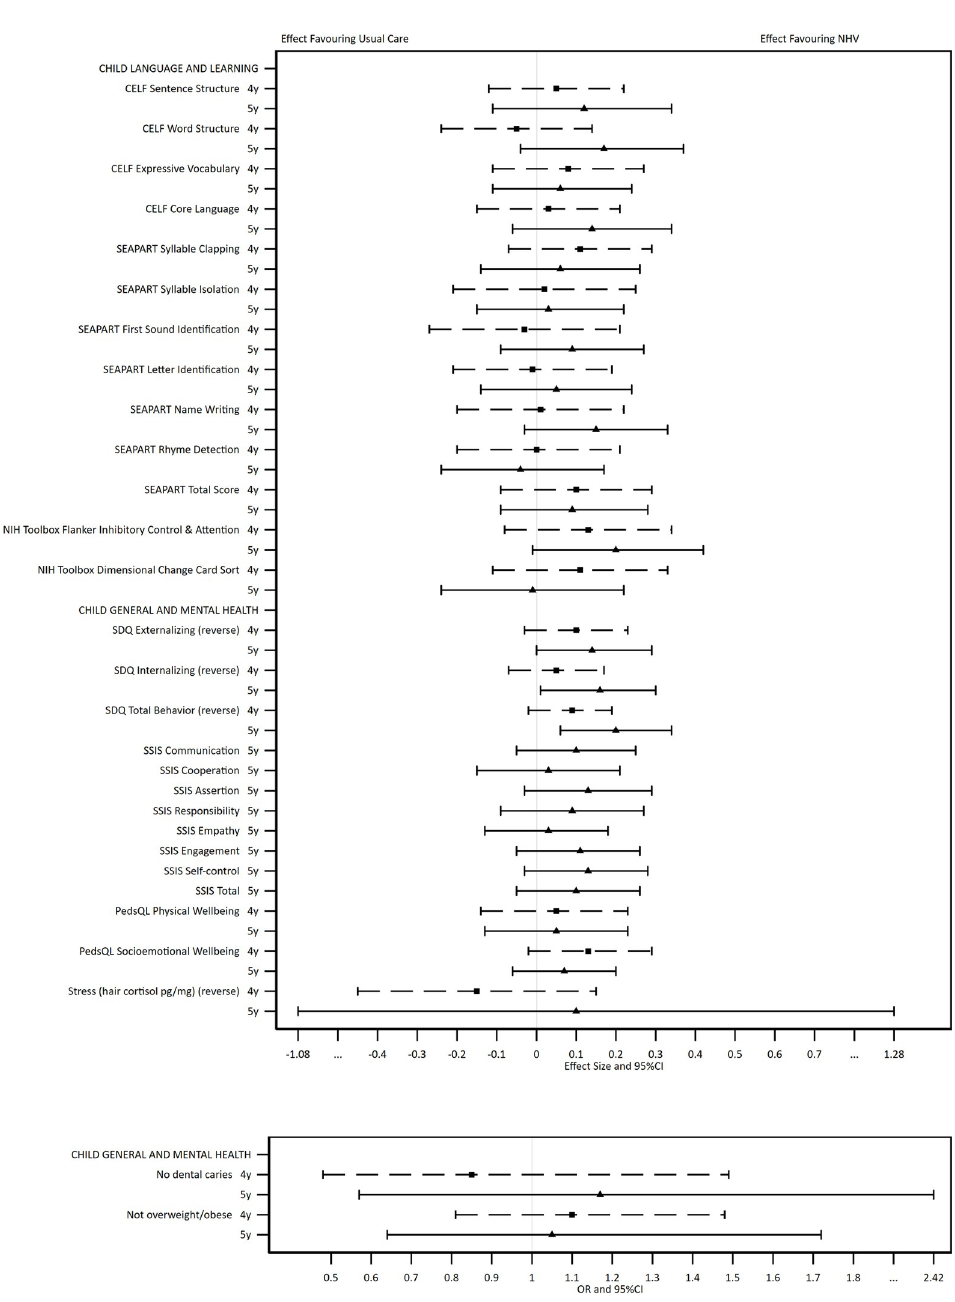
Fig 2. Results of adjusted regression analyses comparing the two trial arms on continuous (top box) and categorical (bottom box) child outcomes at 4 and 5 years, using multiply imputed and inverse probability weighted data.